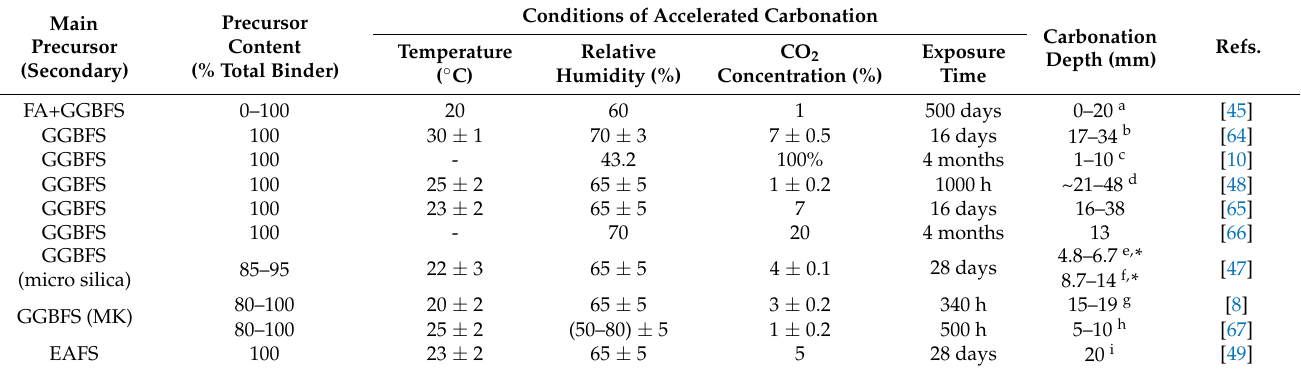
Table 1. Carbonation depth measured via pH indicator of alkali-activated materials exposed to accelerated carbonation under different